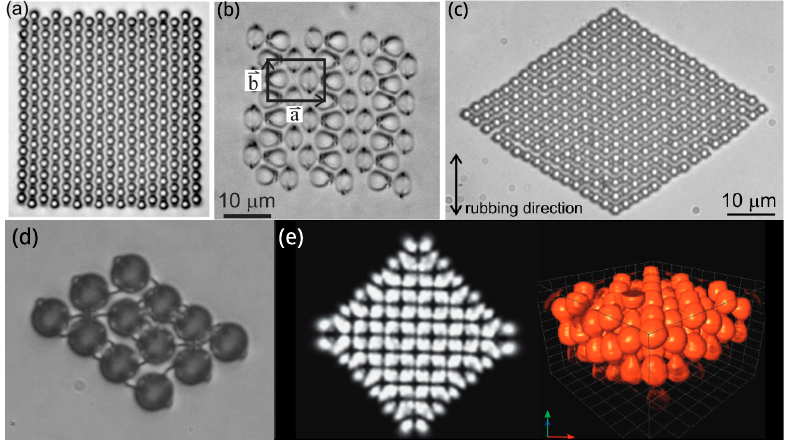
Figure 4. Colloidal assemblies of spherical microparticles in a nematic under different confinement con- ditions. Two-dimensional crystals can be formed from ( a ), ( b ) dipolar-quadrupolar, or ( c )